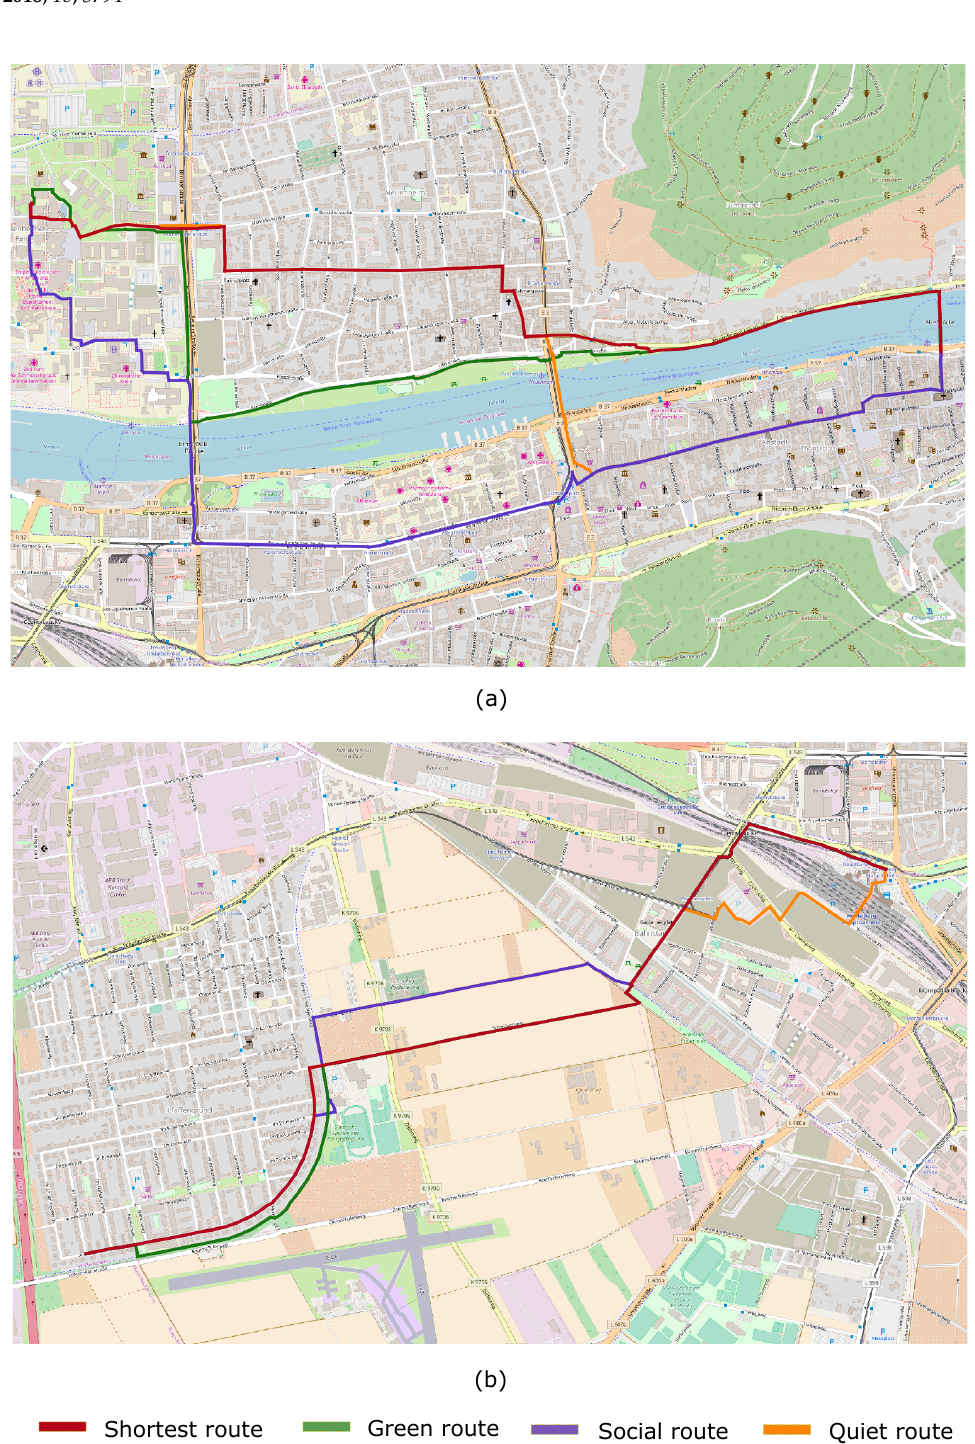
Figure 6. Shortest and alternative walking routes generated for trips 1 and 2 (Figure 5), shown in ( a ) and ( b ) in Heidelberg (Germany). The alternative routes were generated by setting a weight of 2 to the length factor and 8 to the other three factors